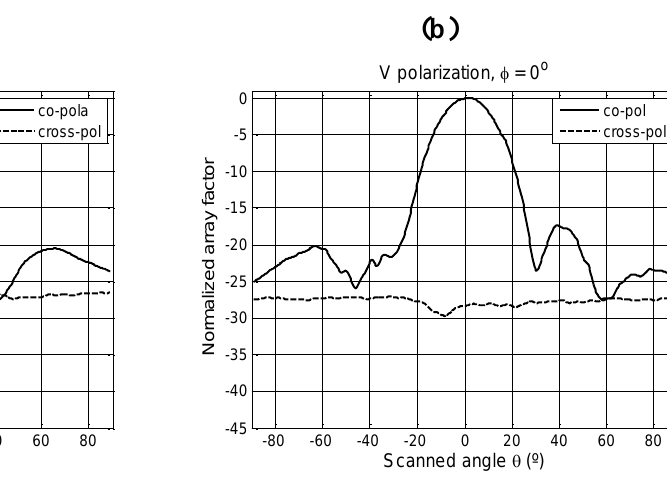
Figure 18. PAU-RAD DBF results in dB for the 0° steered beam and V polarization, (a) polar and cross-polar beams scanning on the φ domain (non-steerable), (b) polar and cross-polar beams scanning on the θ domain